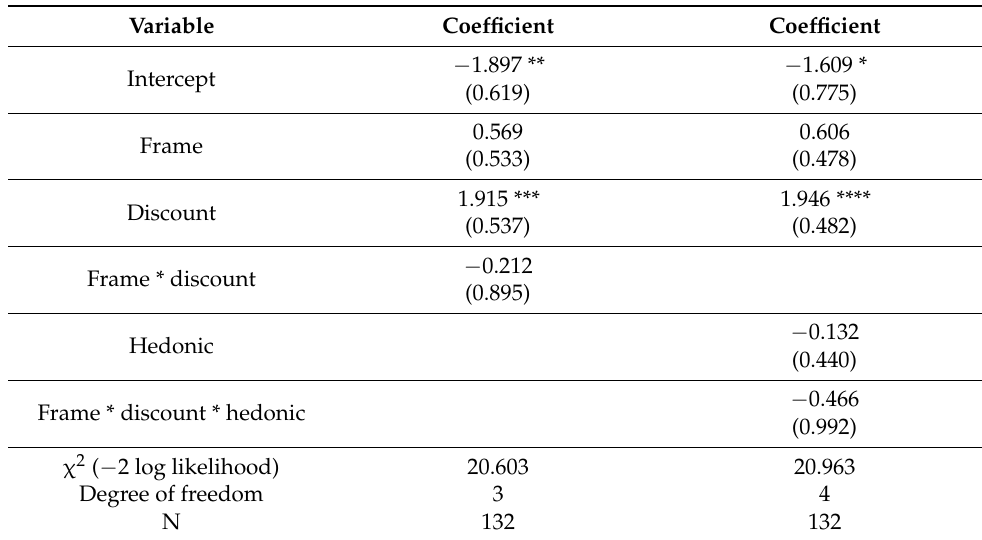
Table 2. Effect of the frame and of discount on purchase quantities (standard error in